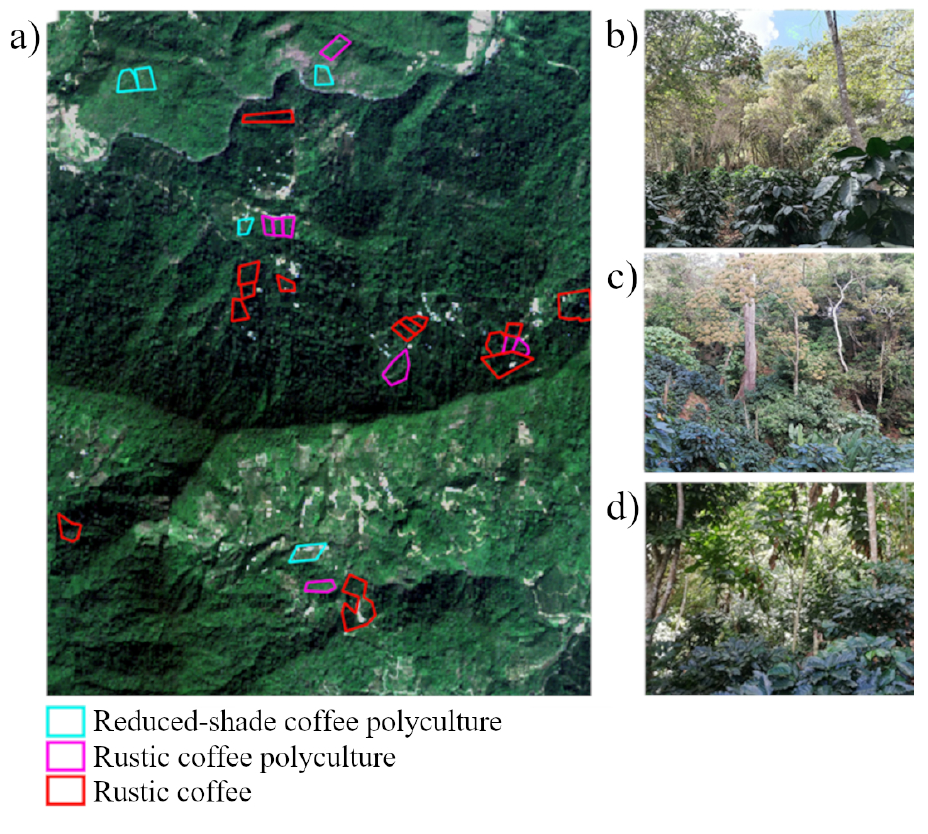
Figure 2. Coffee agroforestry systems defined for the study area. ( a ) Sample polygons of each type of coffee agroforestry system, ( b ) reduced-shade coffee polyculture, ( c ) rustic coffee polyculture, ( d ) rustic